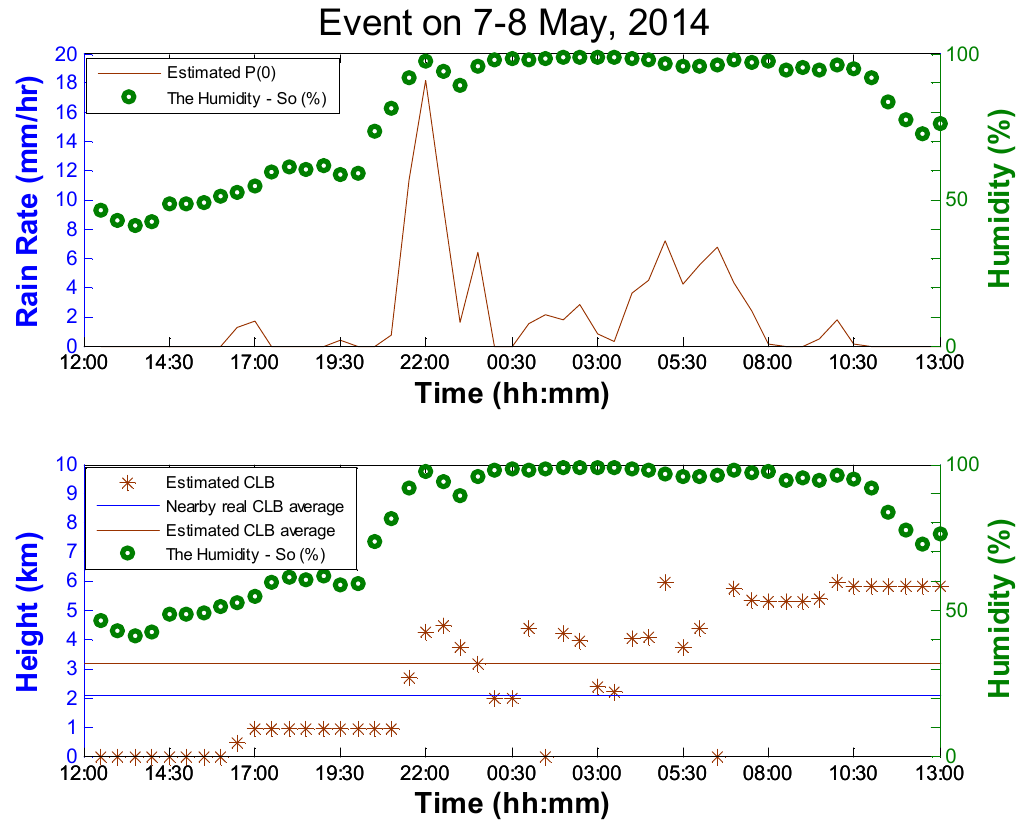
Figure 2. The experiment site area: Southern Israel, the weather radar of the Israeli Meteorological Service (IMS) (white target), Arad and Shani RGs (white triangles), and the commercial microwave link marked with two black antenna markers and the actual microwave link between them (purple).